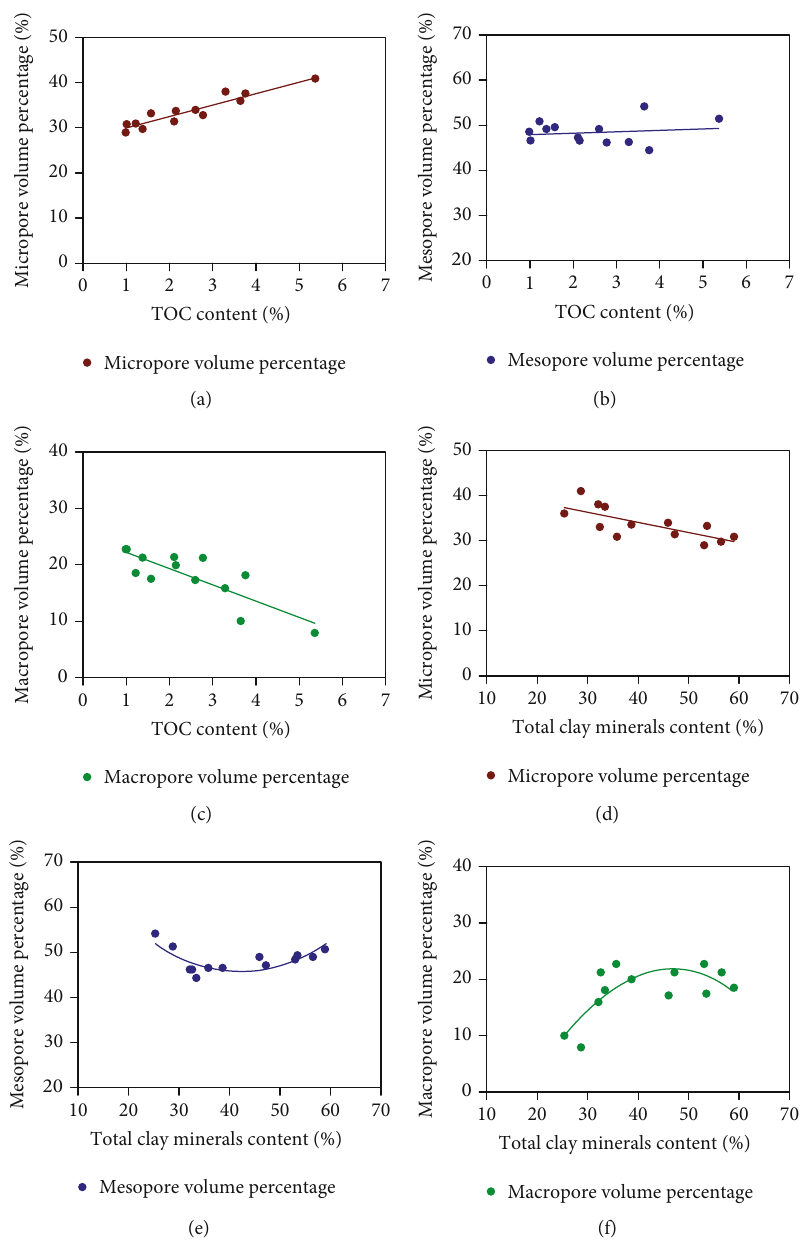
Figure 9: The relationship between (a) TOC content and micropore volume percentage, (b) TOC content and mesopore volume percentage, (c) TOC content and macropore volume percentage, (d) clay mineral content and micropore volume percentage, (e) clay mineral content and mesopore volume percentage, and (f) clay mineral content and macropore volume